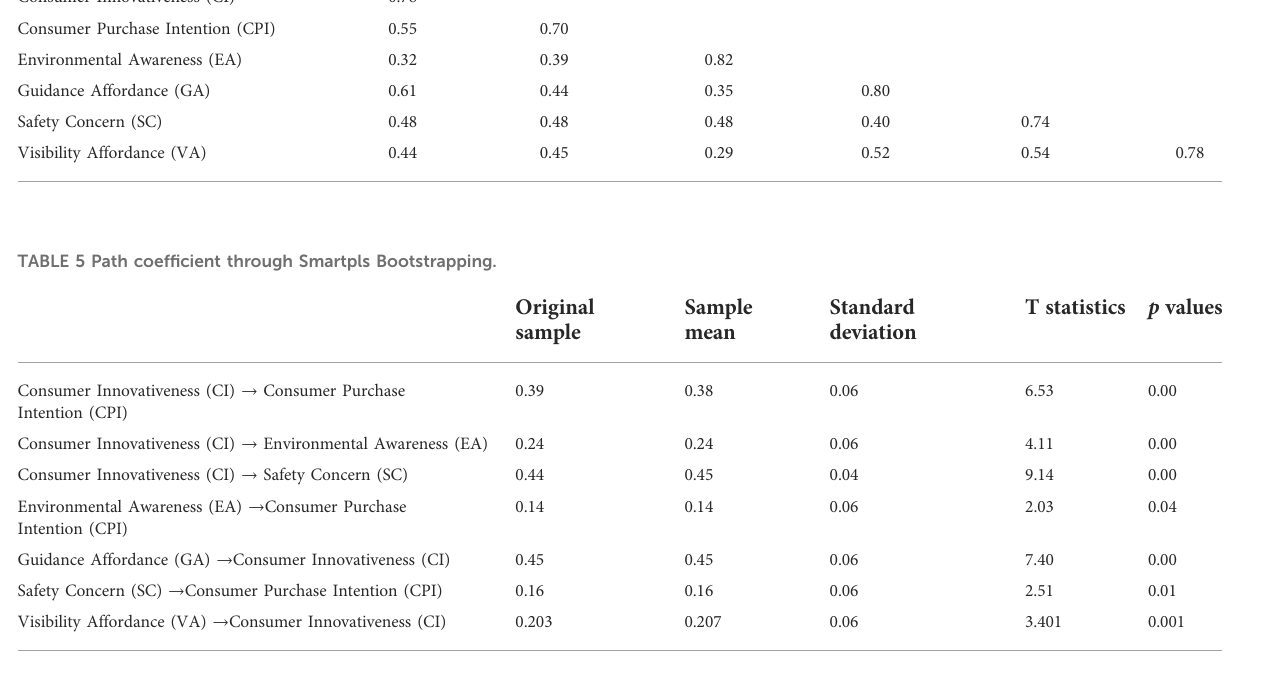
TABLE 6 Direct effects through SmartPLS